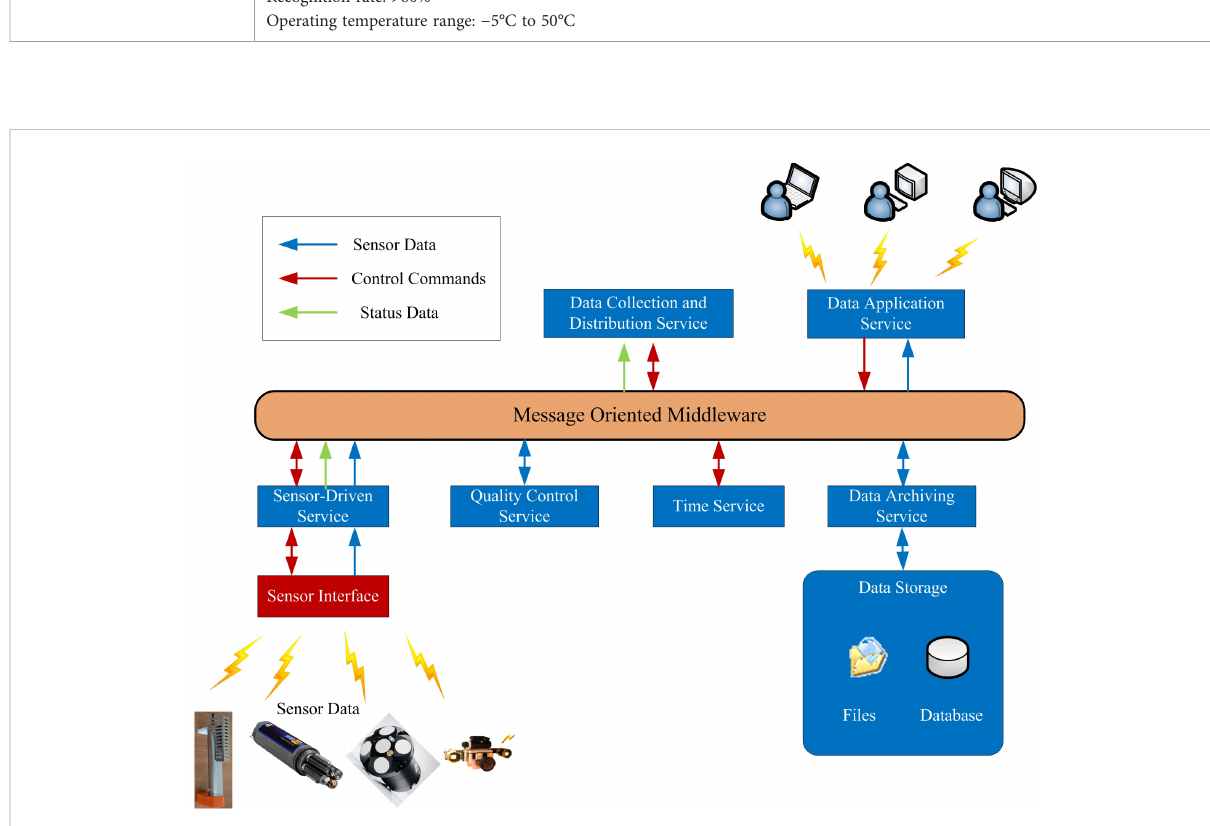
FIGURE 7 Architecture of data acquisition and management